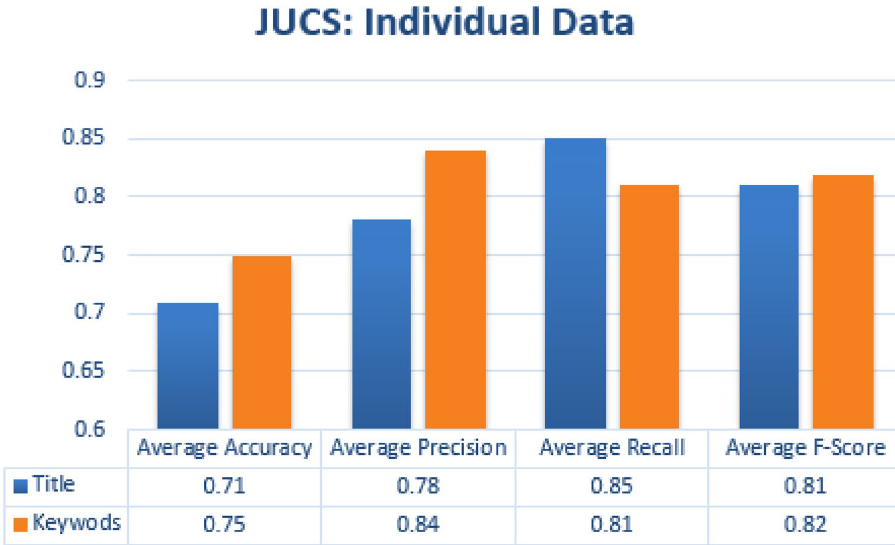
Figure 13. JUCS (individual metadata).